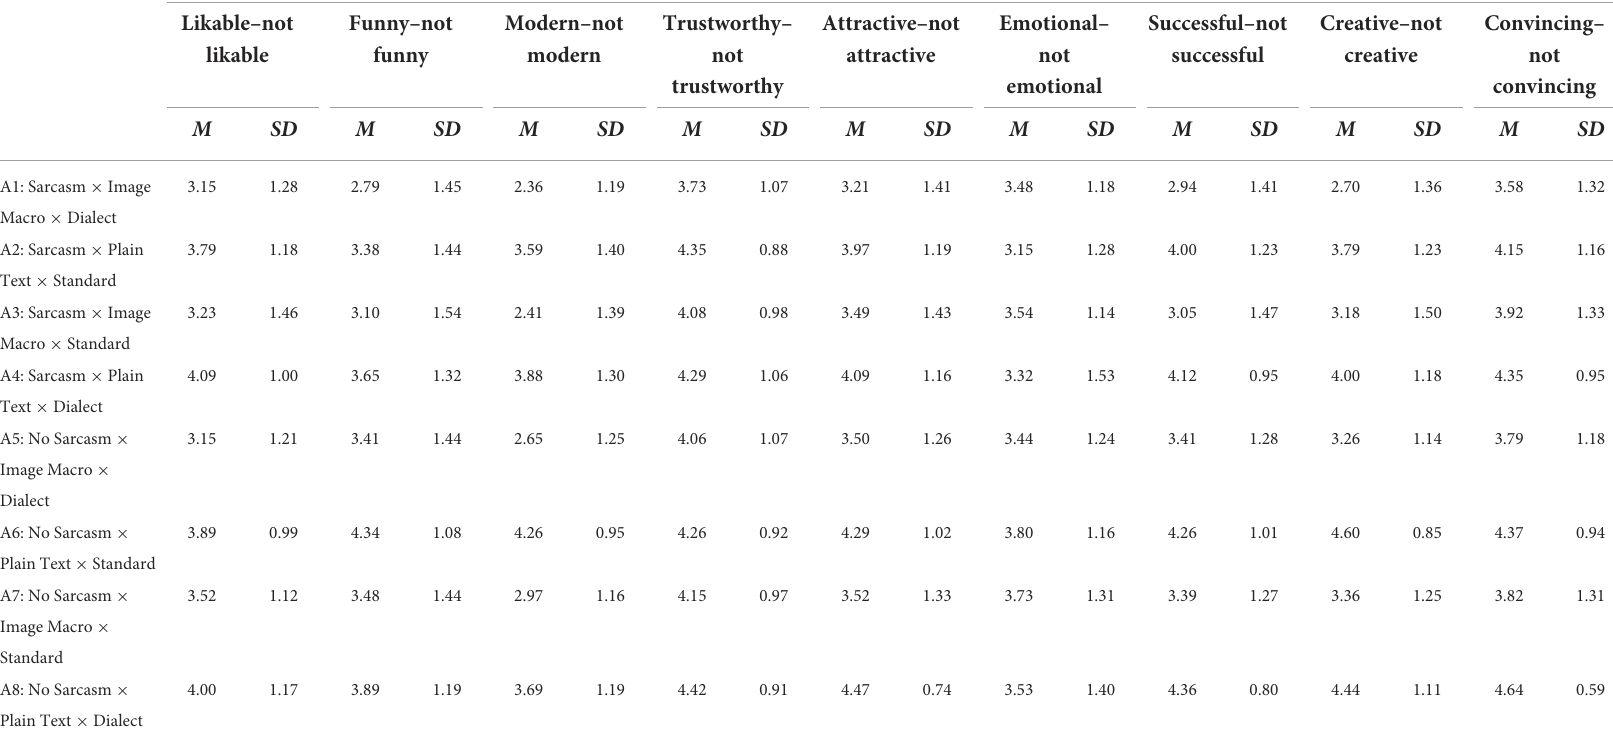
TABLE 2 Perception of the recontextualized political message in study